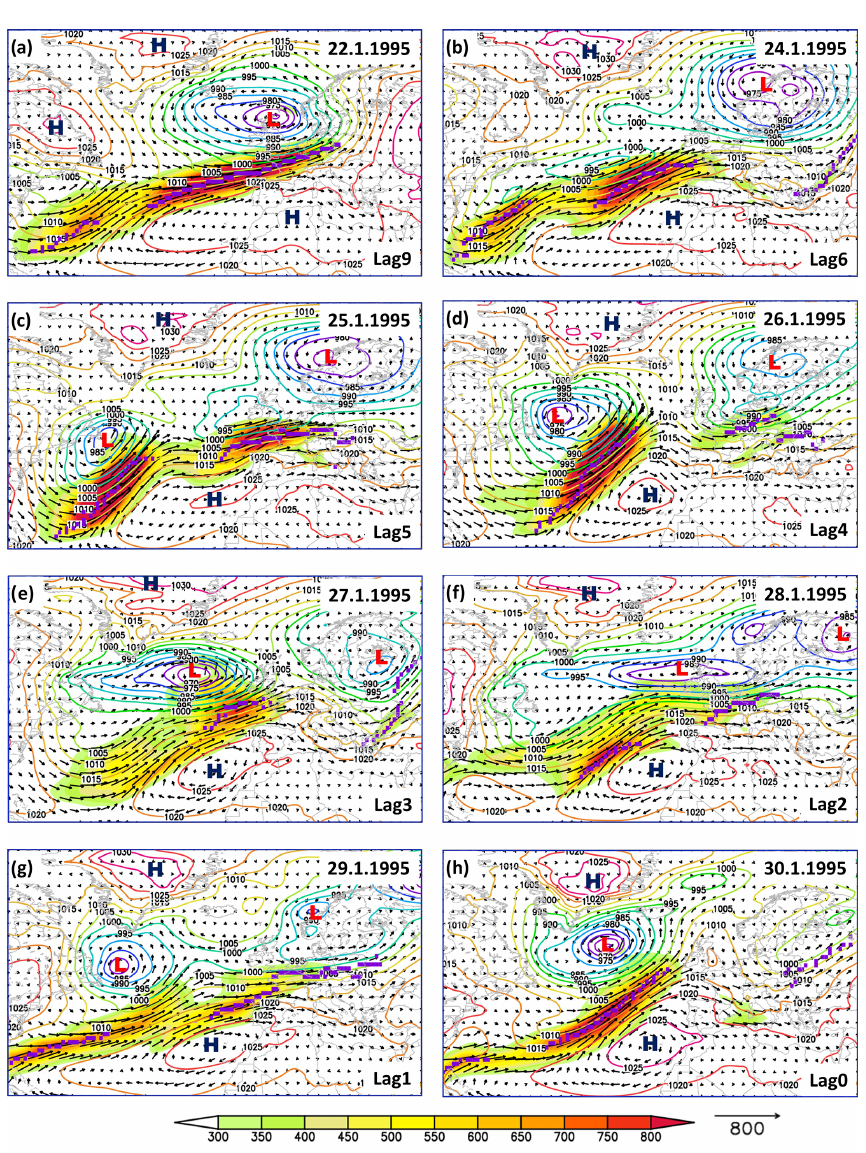
Figure 9. Daily sea level pressure (SLP; colored contour lines), magnitude of the integrated water vapor transport (IVT; shading), direction of the integrated water vapor transport (vectors) and location of the AR axis (magenta line) for different time lags (0–7d) for the 1995 flood event. Units: SLP (hPa) and IVT (kgs − 1 m − 1